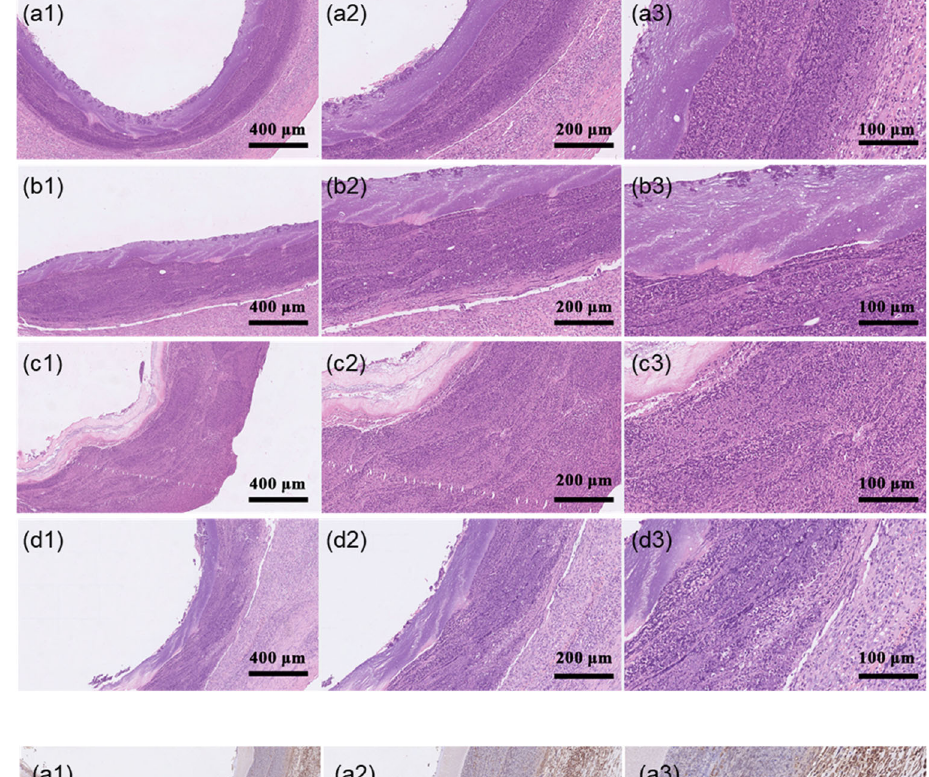
Fig. 14 VEGF staining of bioarti fi cial blood vessels (100x, 200x, and 400x magni fi cation): a1 – a3 Host blood vessel. b1 – b3 Proximal bioarti fi cial blood vessel. c1 – c3 Mid-section of